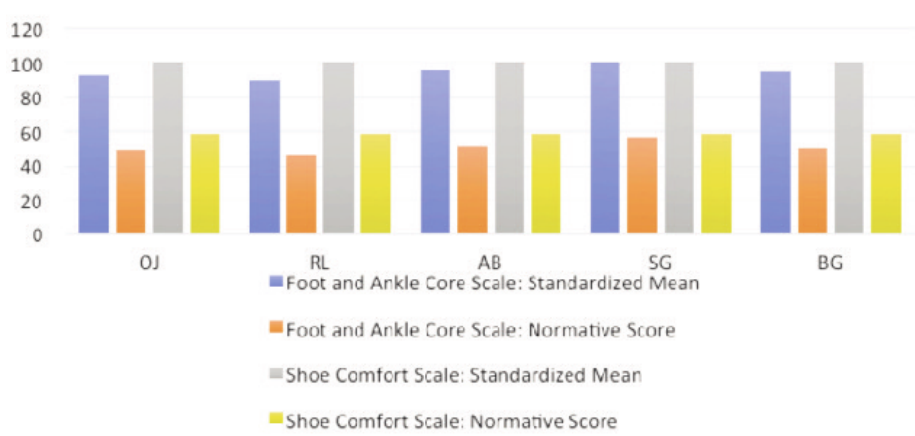
Results of Foot and ankle Outcome Instrument (American Academy of Orthopaedic Surgeons) of the patients on latest follow-